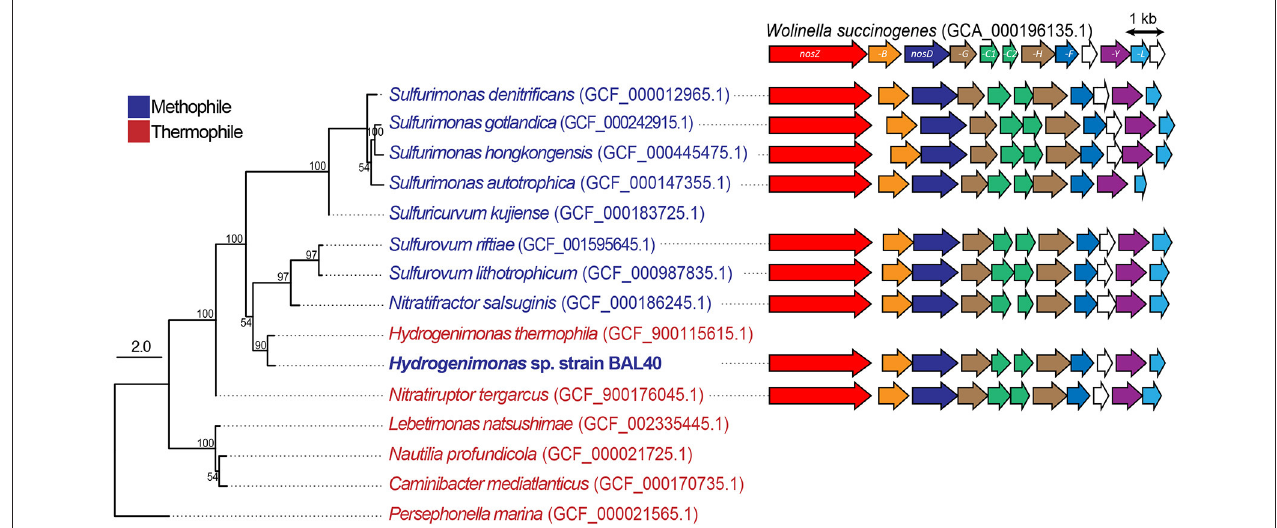
FIGURE 3 | ML tree based on genome sequences and schematic comparison of the nos gene clusters in different Campylobacteria . Bootstrap values based on 500 resampling replicates are shown as percentages at branch nodes. Clade II nosZ and its accessory genes (BDFGHLY) are labeled and colored according to homology across the different